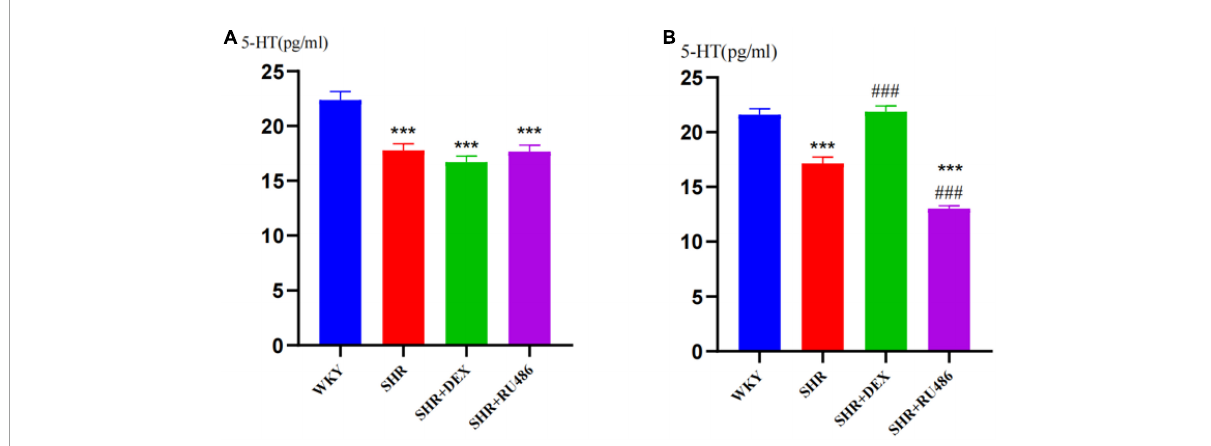
FIGURE4 Levels of 5-hydroxytryptamine (5-HT) in the prefrontal cortex of rats in four groups ( n = 15 in each group) before and after drug intervention. (A) Pre-intervention and (B) post-intervention content of 5-HT in the extracellular liquids of the rat prefrontal cortex, respectively. One-way analysis of variance (ANOVA) with repeated measures followed by post hoc with Tukey test. All data are presented as mean ± SEM. *** p < 0.001, compared to Wista Kyoto rats (WKY) group; ### p < 0.001, compared to spontaneously hypertensive rats (SHR) group.